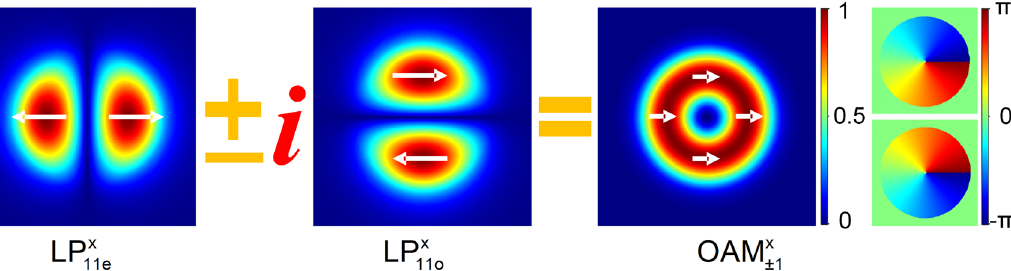
and LP x with ± π /2 phase shift resultsin a linearly polarized OAM mode with 11 e 11 e